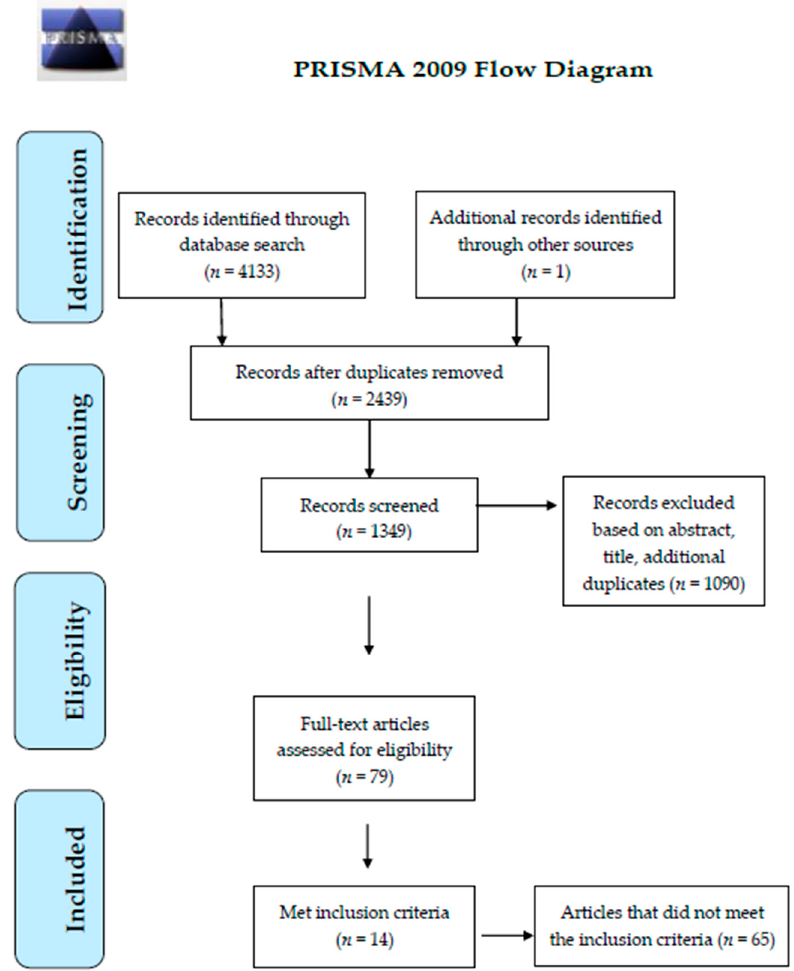
Figure 2. Preferred Reporting Items for Systematic Reviews and Meta-Analyses (PRISMA) flow diagram.